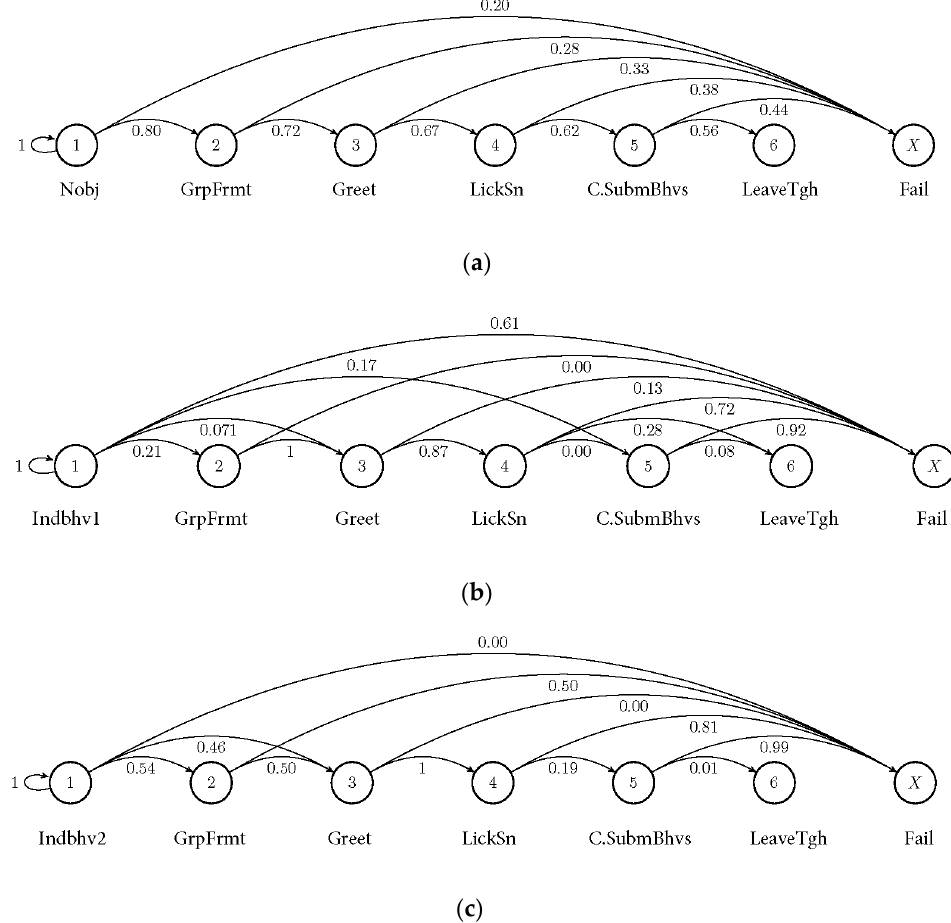
Figure 3. Markov chains representing the probabilities of transition in behavioural state: ( a ) behavioural chain after novel object interaction; ( b ) behavioural chain after individual behaviour “run”; ( c ) behavioural chain after individual behaviour “forage”. Only transitions within the behavioural chain are represented; values are percentages. Behavioural states are defined in Table 4. Initial behaviours are defined in Table 3. Table 6. Initial state and success score of Markov chain calculation ( n = 24).